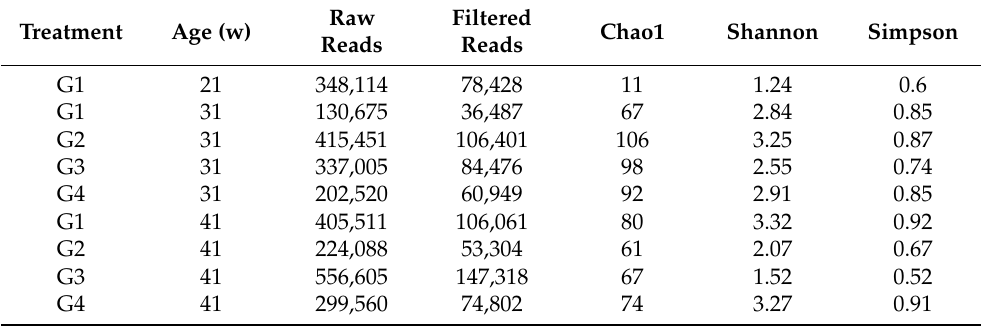
Table 3. Number of sequences and diversity estimators for the different hen’s fecal samples.